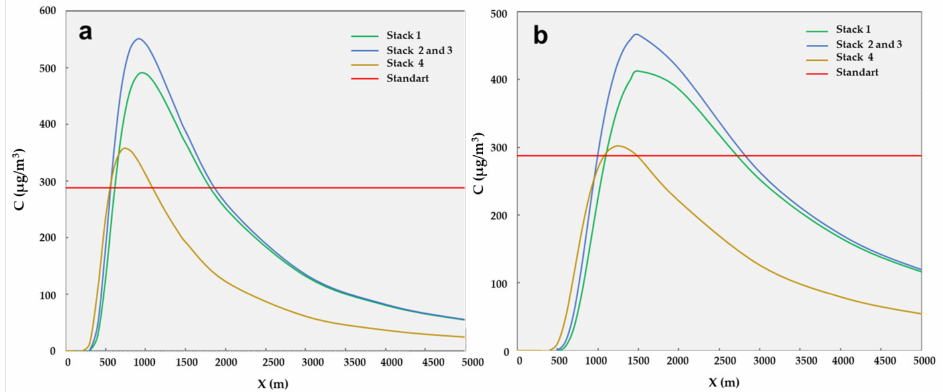
Figure 8. ( a ) Scenario 1 and ( b ) scenario 2. Source: Author’s elaboration.